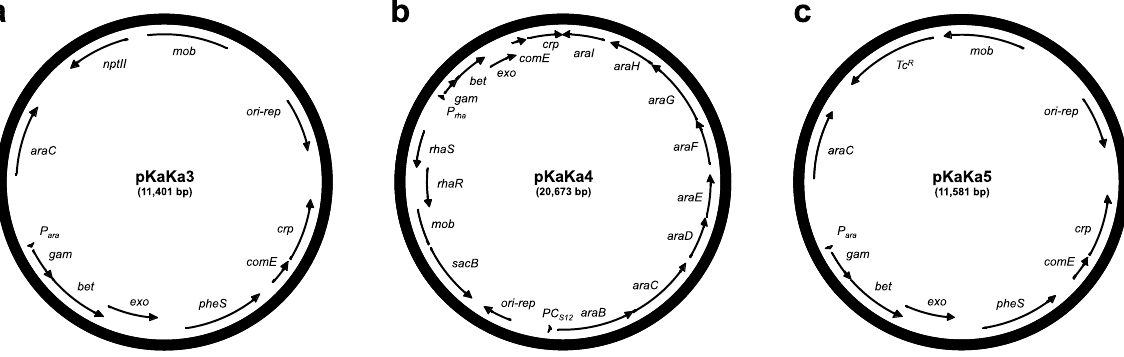
Figure 3. Plasmid maps of pKaKa3, pKaKa4, and pKaKa5 to expand the utility of λ -red recombineering to non-naturally competent Burkholderia species. Abbreviations: araC on pKaKa3 and pKaKa5, activator of the arabinose-inducible promoter (P ara ) from E . coli ; araBCDEFGHI on pKaKa4, B . thailandensis arabinose utilization operon 38 ; gam - exo - bet , λ -red recombineering genes 39 ; mob ; RP4-dependent conjugal origin of transfer of B . bronchiseptica cryptic plasmid pBBR1; ori-rep ; bhr replicon of B . bronchiseptica pBBR1 plasmid 40 ; nptII , encodes kanamycin resistance 41 ; P ara , arabinose inducible promoter 42 ; P rha , rhamnose inducible promoter 43 ; PC S12 , constitutive promoters of B . pseudomallei and B . cenocepacia rpsL gene 44 ; pheS , engineered gene encoding a mutant version of α -subunit of phenylalanyl tRNA synthase 45 ; rhaR and rhaS , regulators of the rhamnose inducible promoter 43 ; sacB , encoding for a modified levansucrase counter-selectable marker 46 . Tc R , tetracycline resistance.